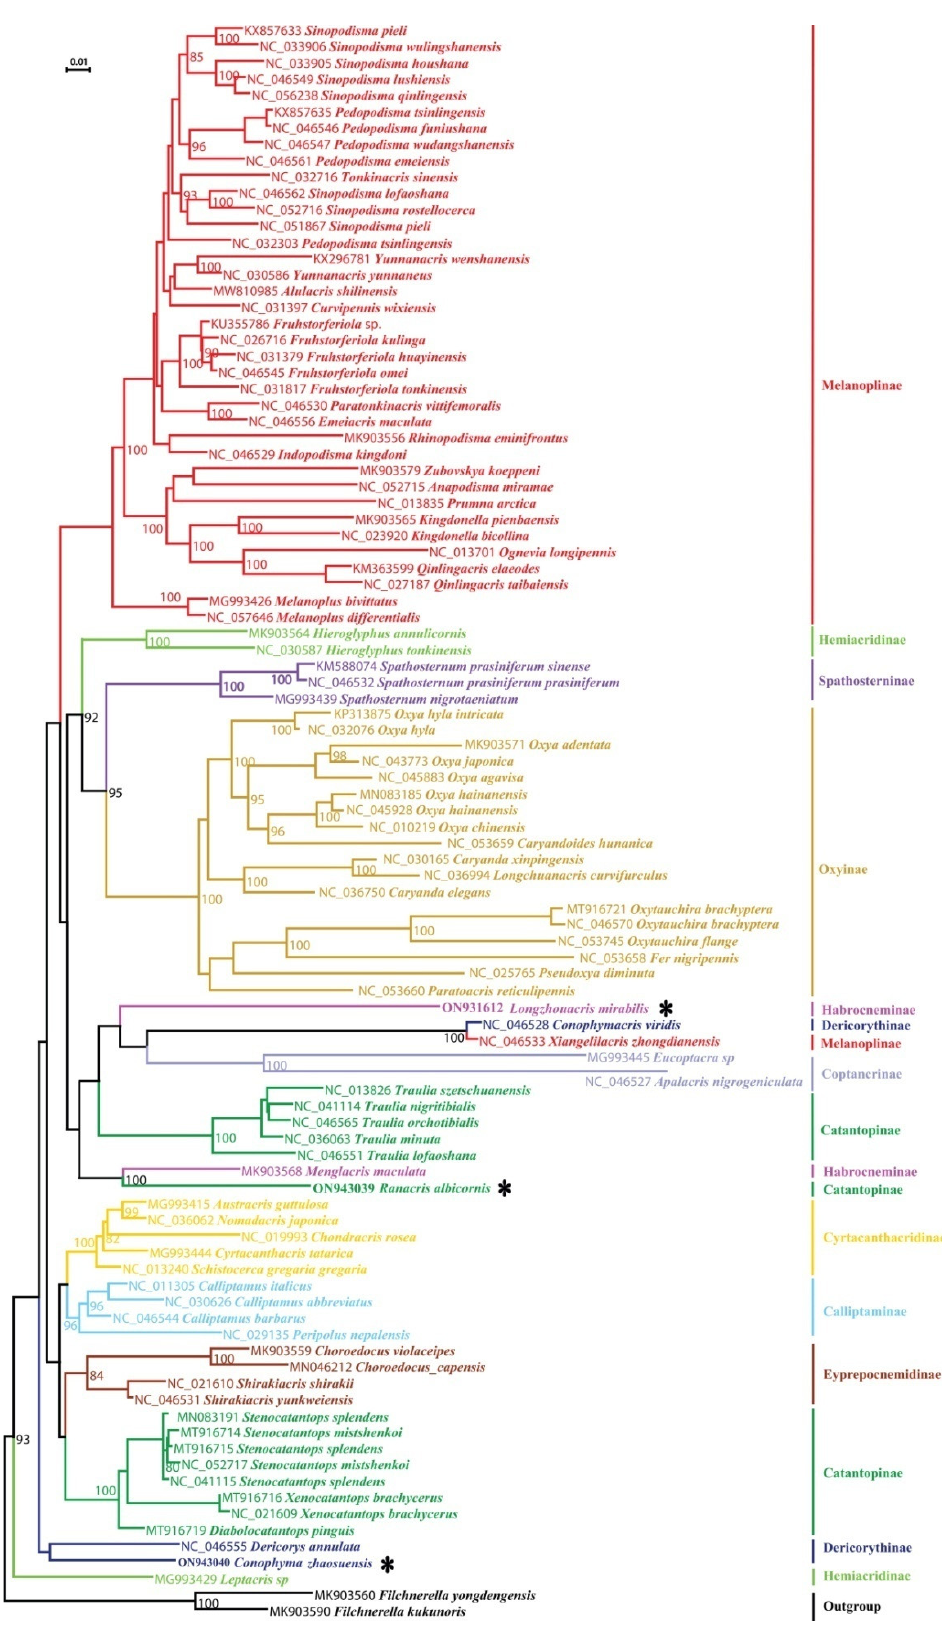
Figure 3. Phylogenetic tree reconstructed from amino acid sequences of the 13 mitochondrial PCGs using maximum likelihood with MtOrt model. The asterisk indicates the three newly sequenced species.